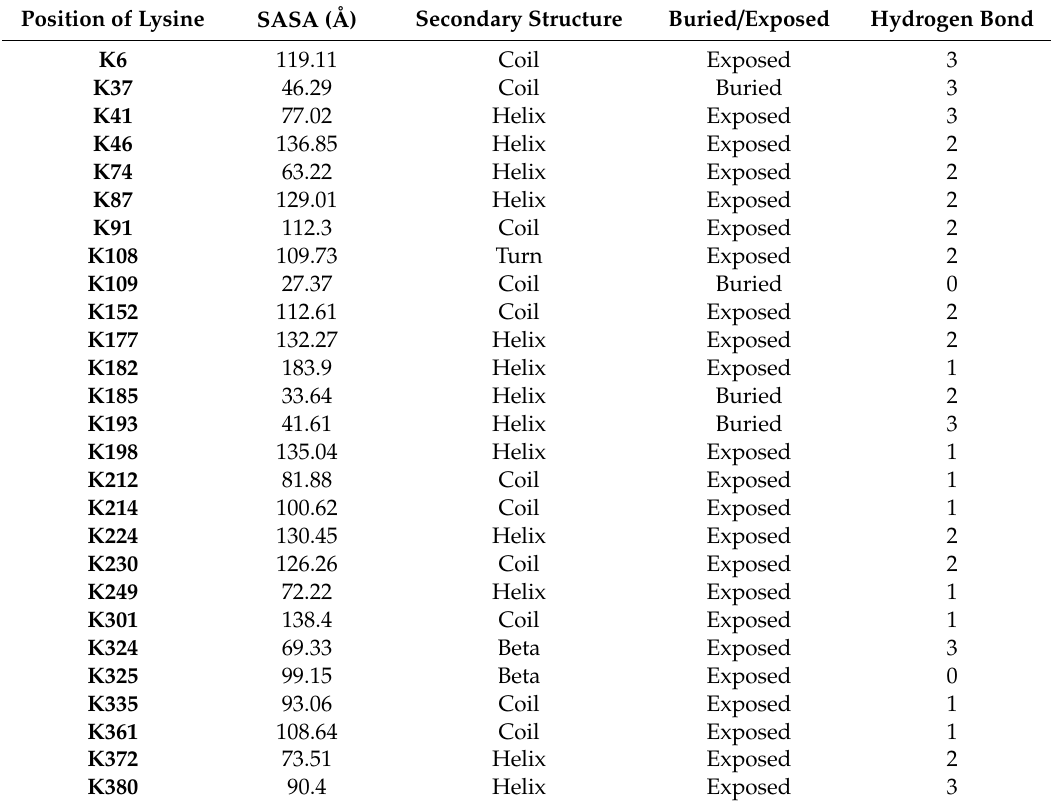
Table 1. Analysis of 27 lysine residues in the wild type (WT) lipase based on SASA value, secondary structure, buried / exposed and hydrogen bond. The values of SASA and the position of each residue whether buried / exposed were analysed by HotSpot Wizard 2.0. Meanwhile, the secondary structure and local hydrogen bond number were analysed using Chimera